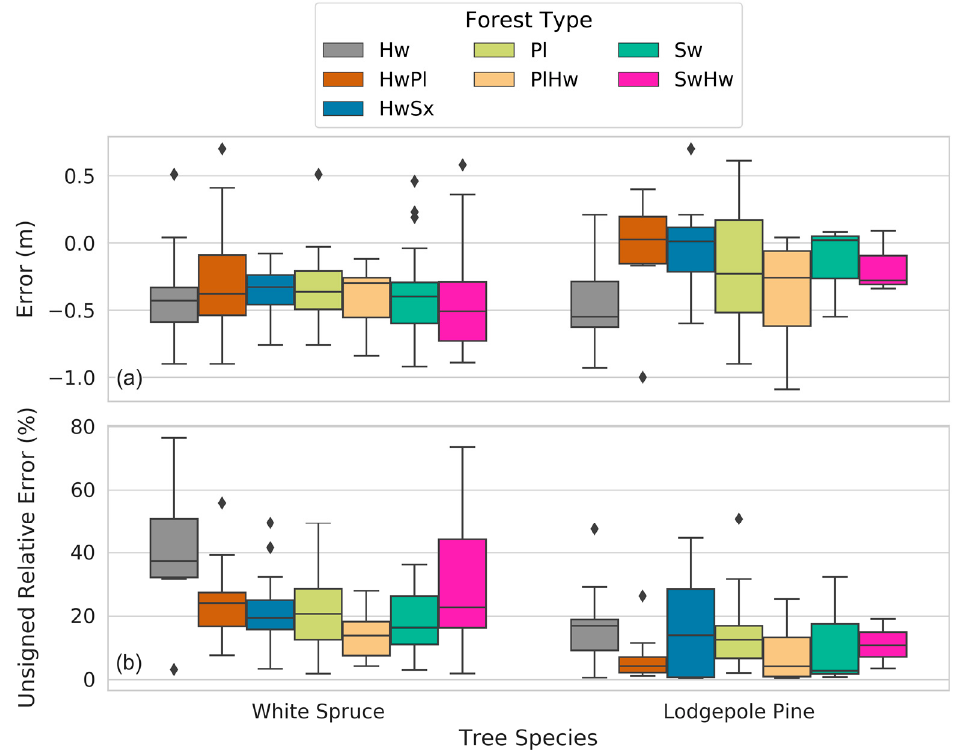
Figure 11. Error ( a ) and unsigned relative error ( b ) distributions for lodgepole pine and white spruce individuals sampled from seven di ff erent forest types. The black diamonds represent